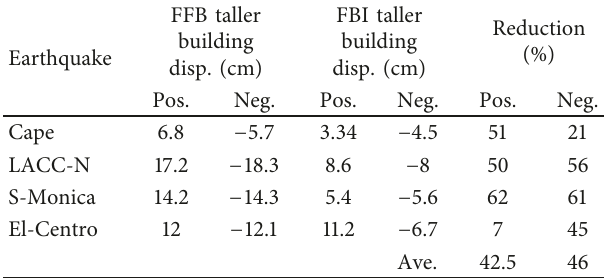
Table 3: Relative displacement of the taller FFB and FBI buildings under considered